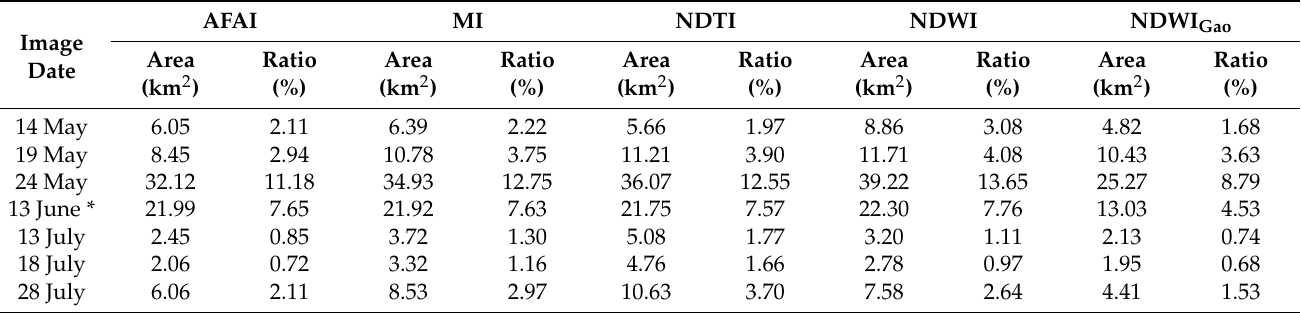
image taken on 13 June were cloud-free